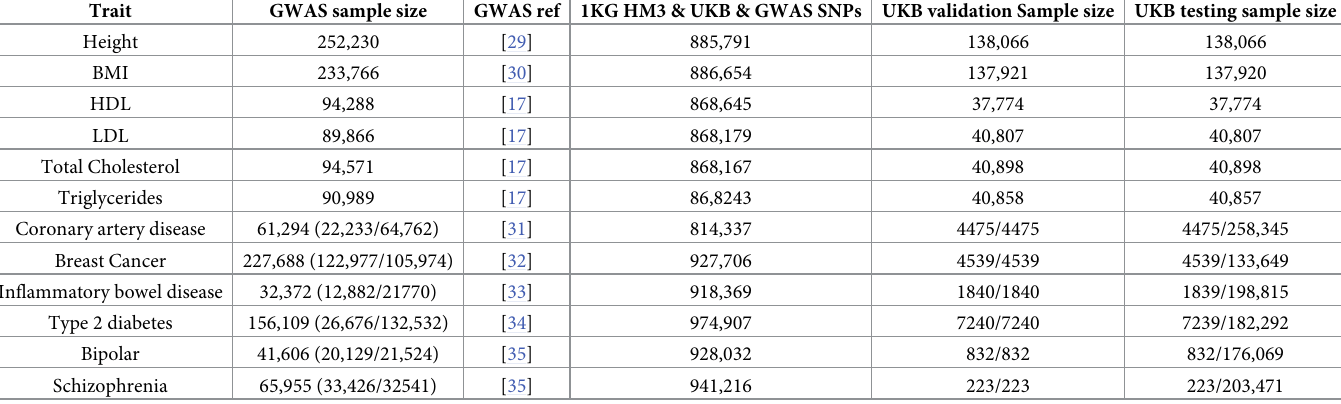
Table 1. Summary information about the sample size and SNPs in GWAS summary statistics and UK Biobank datasets. For binary traits, effective sample size was used ( 4 � N case � N control ) and the validation datasets consisted of equal numbers of cases and controls. If the summary statistics included sample sizes for individual SNPs, the N case þ N control median of all SNPs passing QC was reported. For binary traits, the number of cases and controls were reported in the parenthesis.